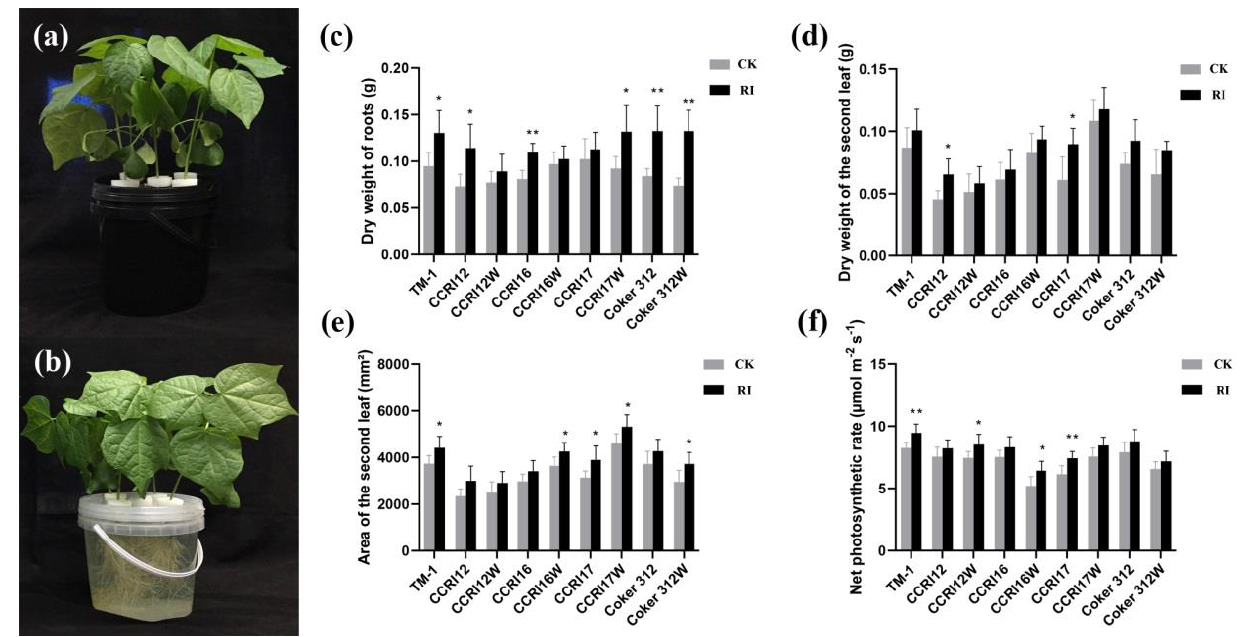
Figure 1. The effect of root illumination on the phenotype of the glanded and glandless cotton seedlings. ( a ) the cotton seedlings without root illumination (CK); ( b ) the cotton seedlings with root illumination (RI); ( c , d ) the dry weight of the roots and the second leaf in glanded and glandless cotton with and without RI; ( e ) the area of the second leaf in glanded and glandless cotton with and without RI; ( f ) the net photosynthetic rate in glanded and glandless cotton with and without RI. Error bars in figures represent standard deviation (SD) value ( n = 9), * indicate significance at p < 0.05, ** indicate significance at p < 0.01.